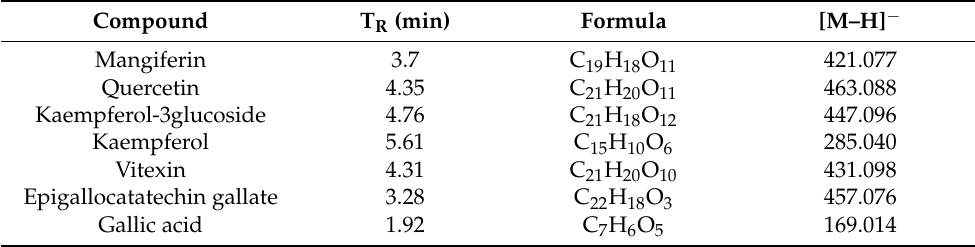
Table 5. Quantified compounds by UPLC-MS in myrtle leaf precipitates.